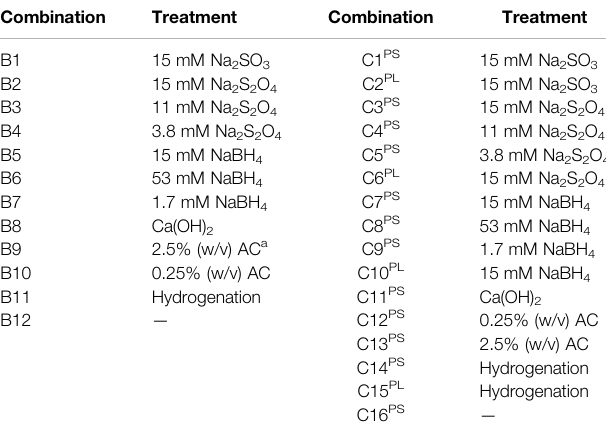
TABLE 2| Experimental conditions for Series B inwhichsix conditioning methods for pretreatment slurry (15% WIS) were compared and experimental conditions for Series C including treatments of pretreatment slurry (PS) and pretreatment liquid (PL) with and without addition of sodium dithionite, sodium sul fi te, sodium borohydride, calcium hydroxide, activated charcoal, and